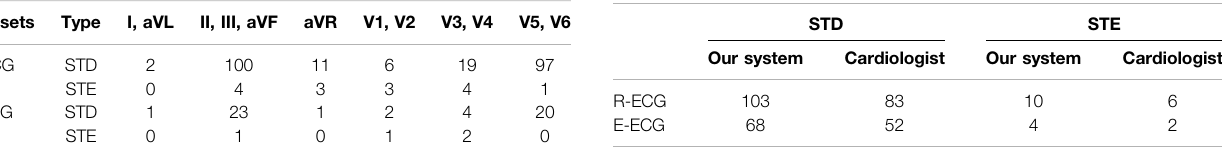
TABLE 5 | The distribution of the ST-segment depression and elevation in every lead group.